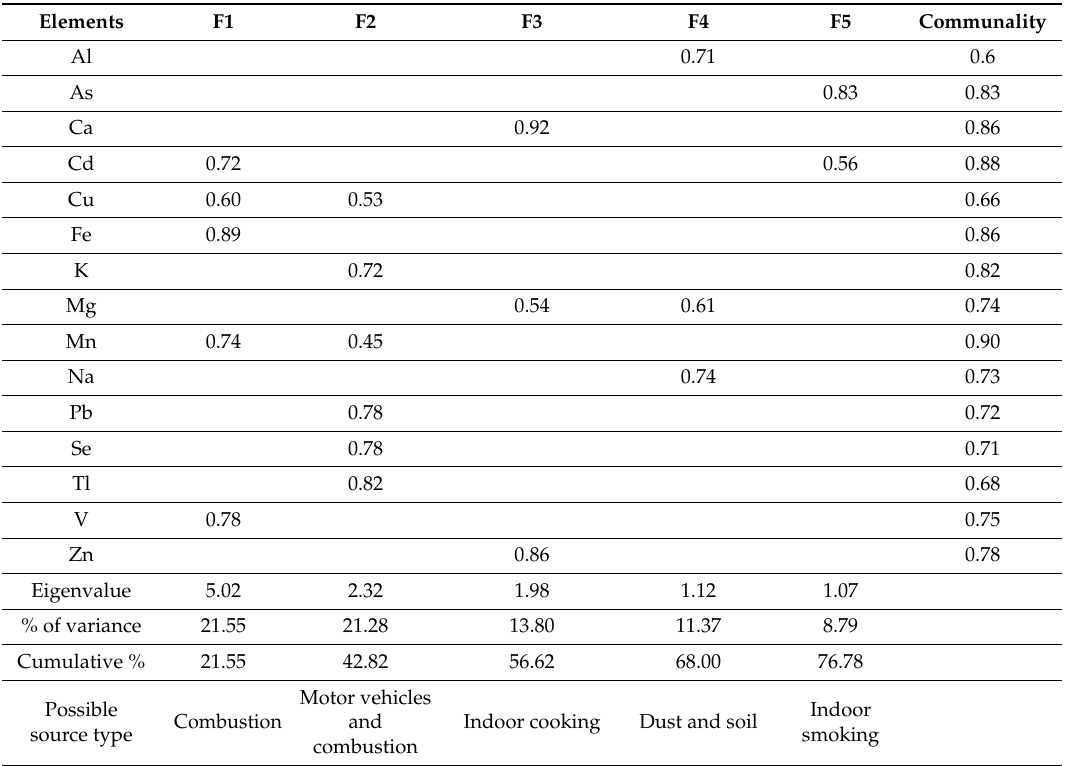
Table 6. Factor analysis for indoor PM 2.5 (all